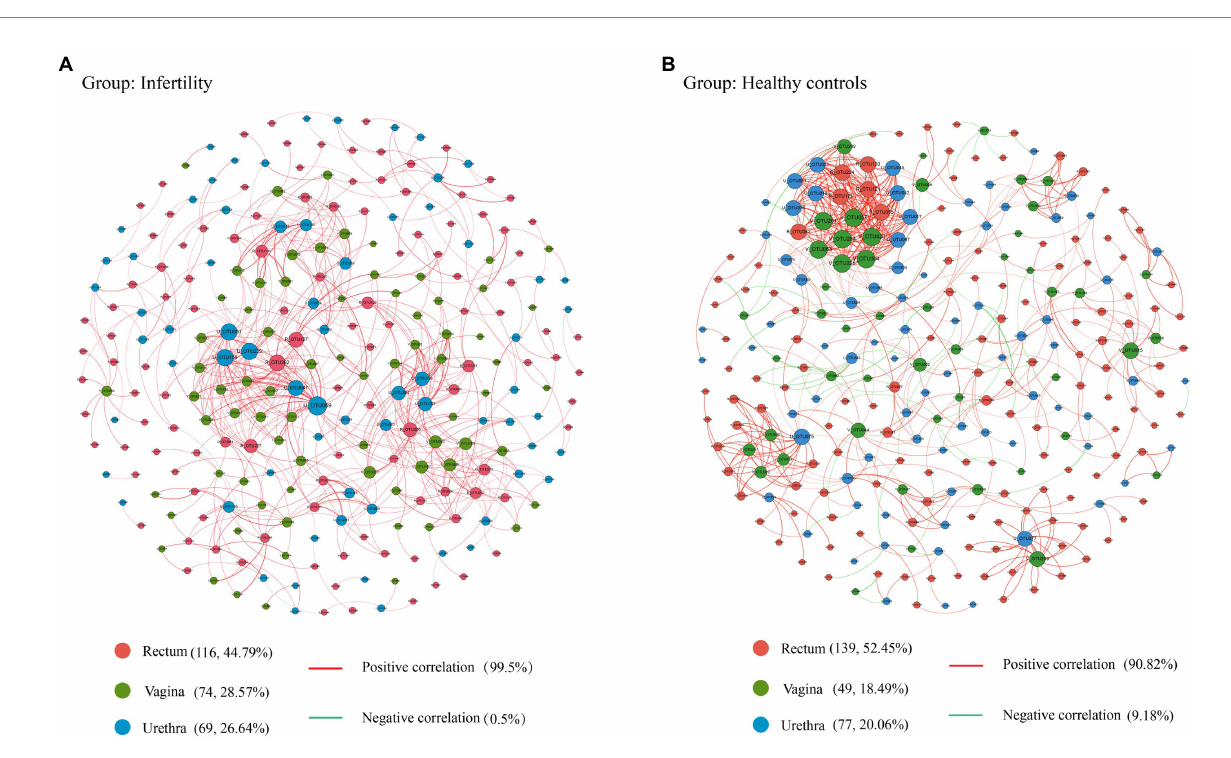
FIGURE 6 OTU correlation network diagram among three different parts of rectum, vagina, and urethra. (A) species interaction patterns among different parts in infertile patients, (B) species interaction patterns among different parts in healthy